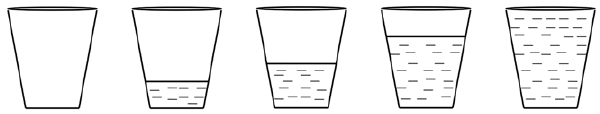
Figure 1. Visual representation of 5-point scale employing glasses with varying levels of water. The anchoring of the empty and full glasses varied according to the questions asked (see text). doi:10.1371/journal.pone.0047291.g001 PLOS ONE |